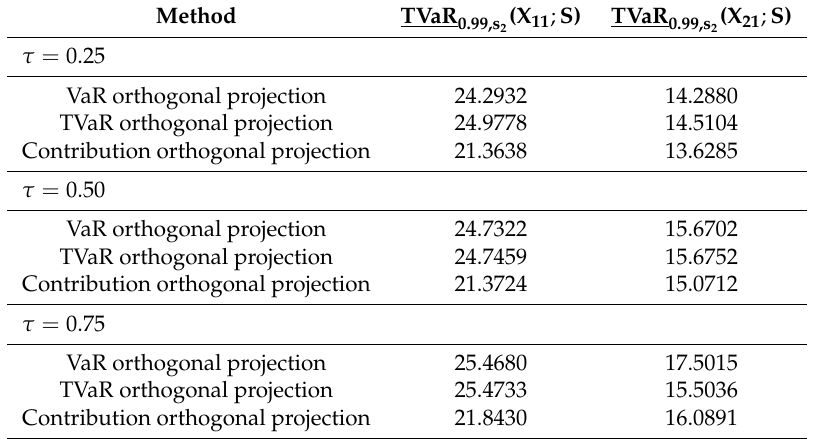
Table 1. Numerical results of the three orthogonal projection methods with varying dependence